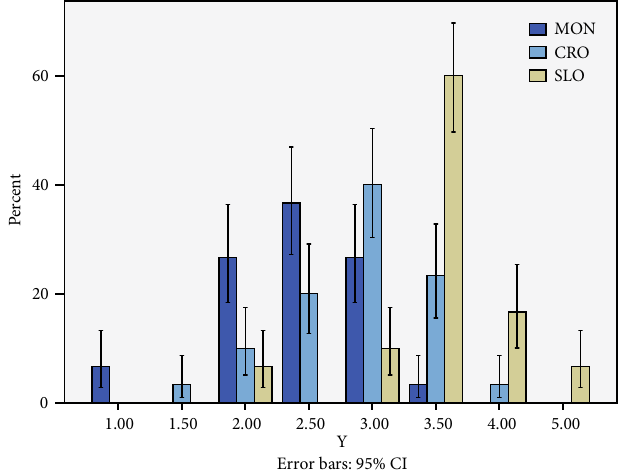
Figure 7. The percentage of estimates from 1 to 5 in the set of dependent variable (Y) (source: calculated by